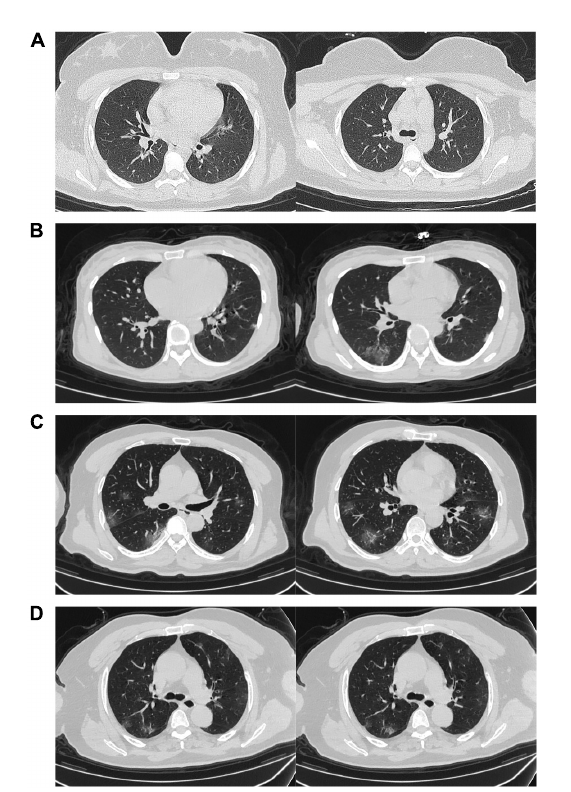
FIGURE2 Representative chest CT images. (A) Transverse chest CT images for a 16-year-old female infected with Omicron only showing ground-glass opacity on day four after symptom onset. (B) Transverse chest CT images for a 35-year-old female infected with Omicron showing signs of bilateral pneumonia on day four after symptom onset. (C) Transverse chest CT images for a 51-year-old male infected with Omicron showing signs of bilateral pneumonia on day three after symptom onset. (D) Transverse chest CT images for a 73-year-old male infected with Omicron showing multiple bilateral pneumonia on day six after symptom